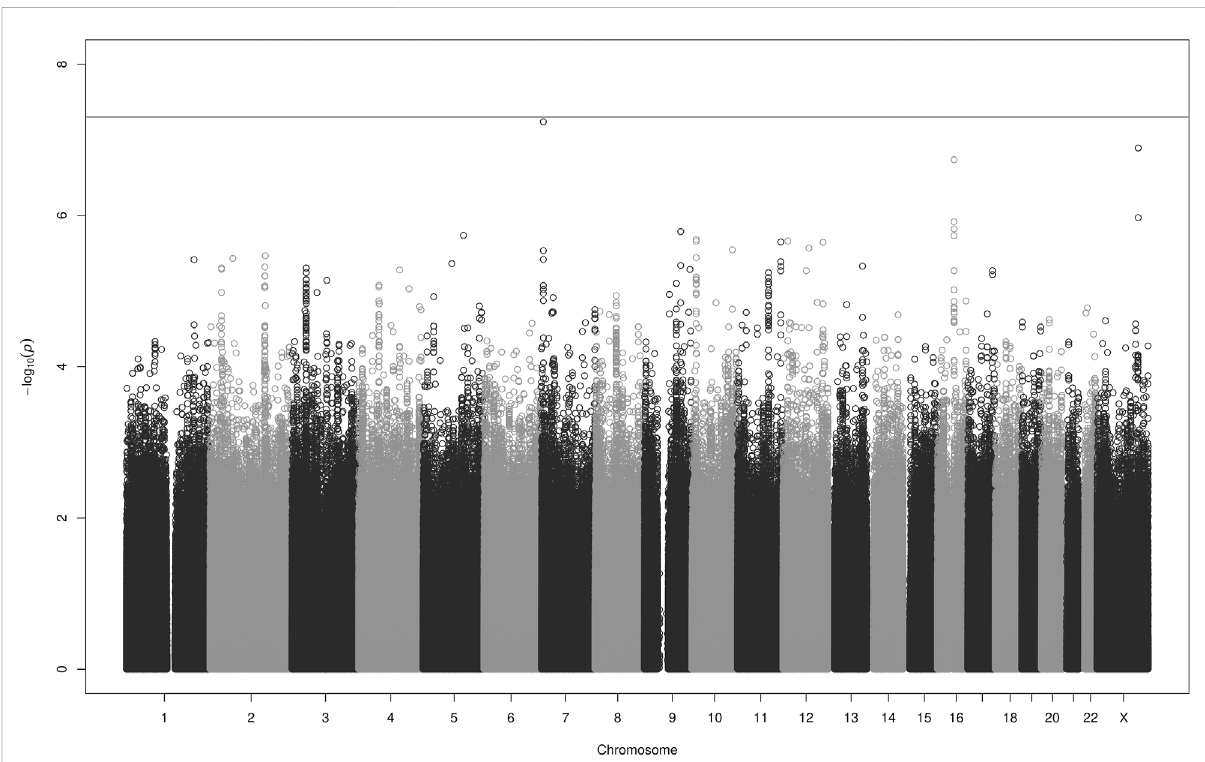
FIGURE 1 Manhattan plotfor theGWASanalyses ofapixabanAUC ss in1,325patientsadjusted for thecovariateslisted inTable 3.The greyline denotes the genome-wide signi fi cance level p < 5 × 10 − 8